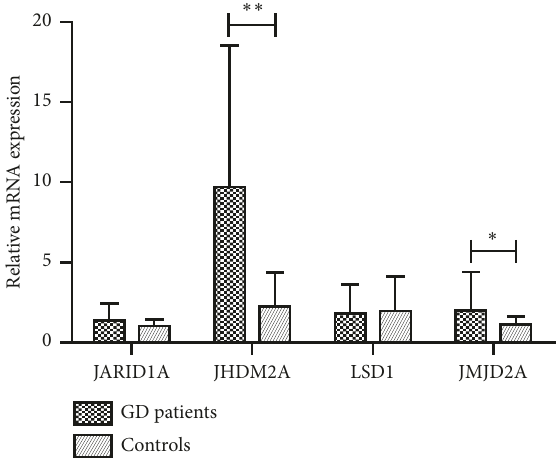
Figure 1: Global histonemethylation levelsin PBMCs from patients of GD and healthy controls. Mean global histone H3K9 methylation level was significantly decreased in PBMCs from GD patients in contrast to healthy controls ( ∗ , P=0.007).